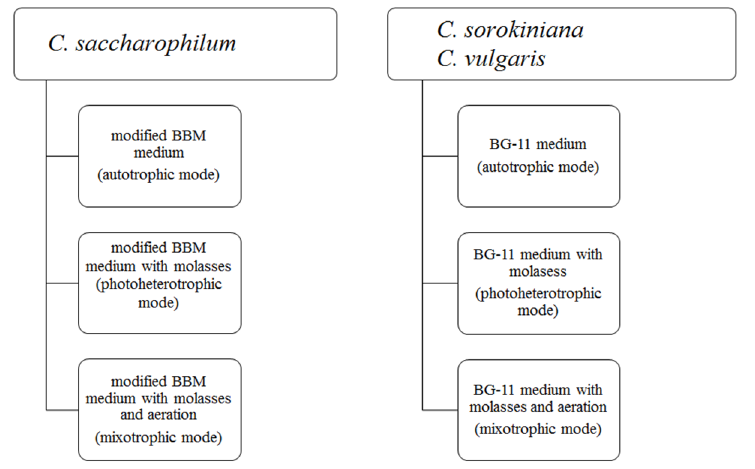
Figure 6. Scheme of the experiment.